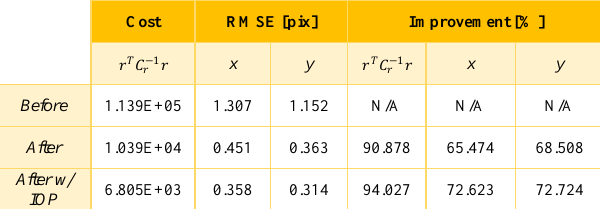
Table 7: Reprojection errors of fluoroscopic systems 1 and